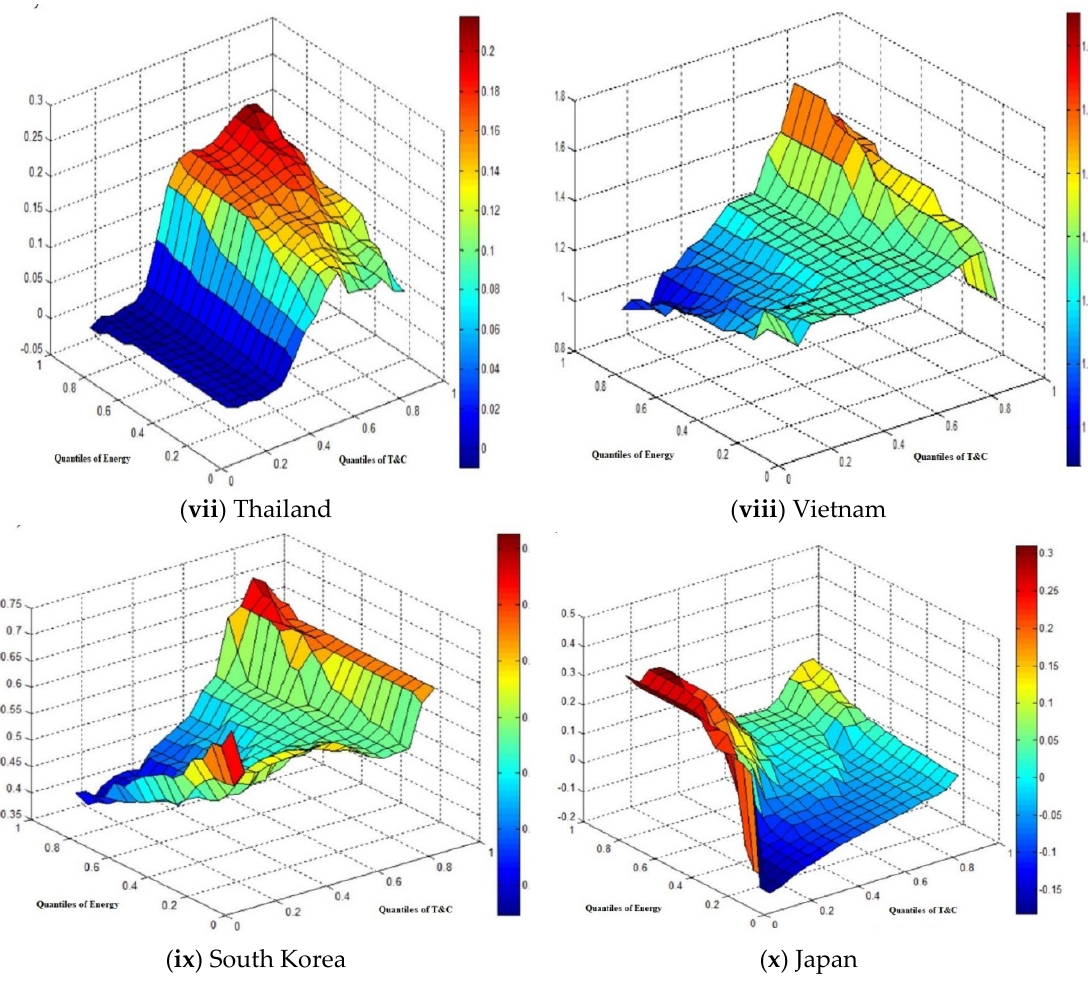
Figure 1. Results of quantile-on-quantile regression.